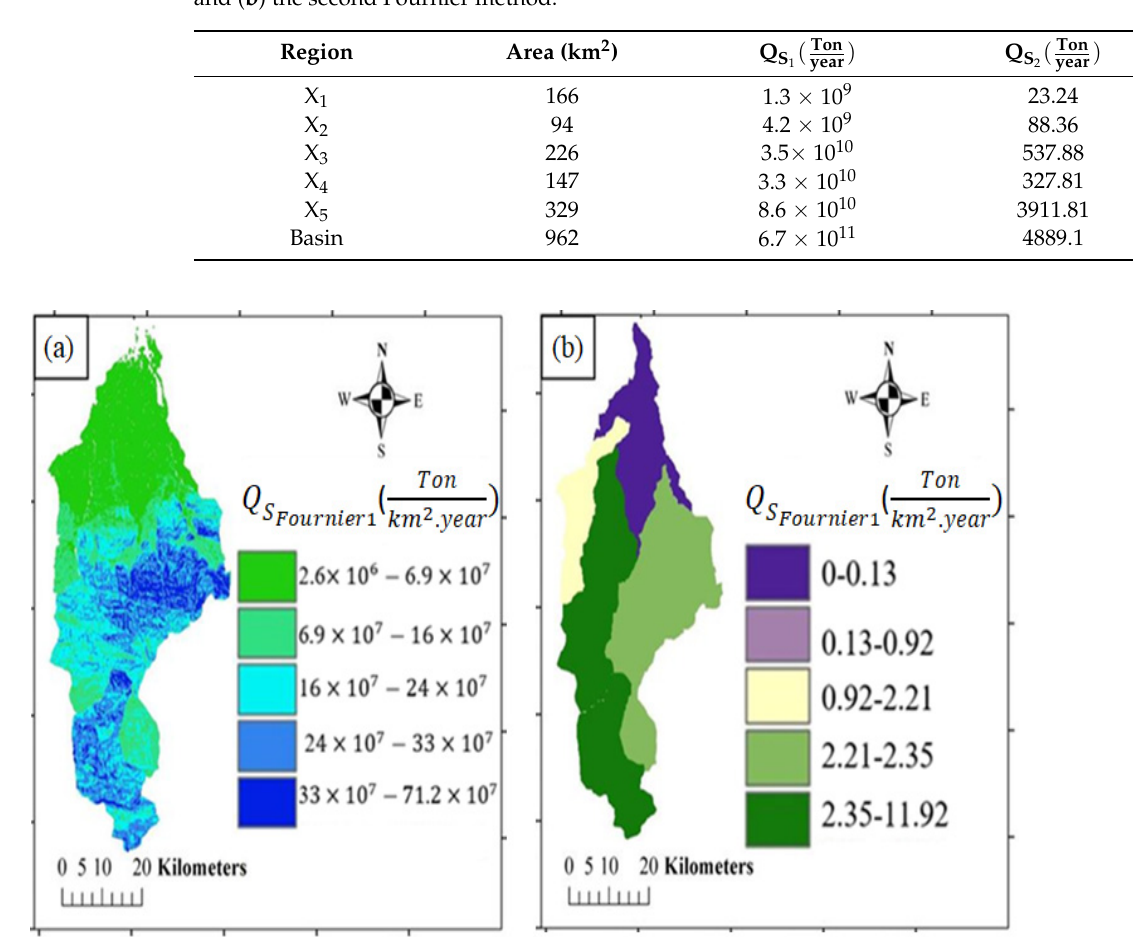
Figure 8. Annual sediment yield based on ( a ) the first Fournier method and ( b ) the second Fournier method.